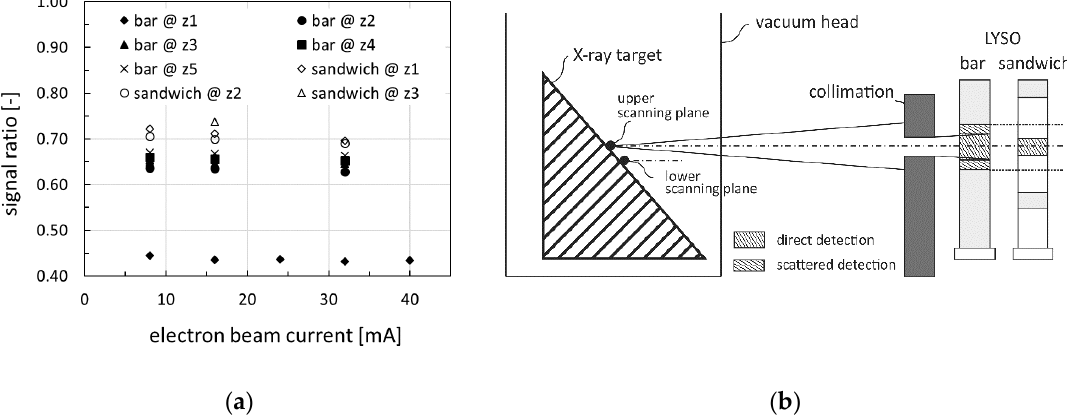
Figure 13. ( a ) Signal ratio between indirectly and directly exposed detectors for di ff erent electron beam currents, detector exposure heights, and MPD design configurations. ( b ) Sketch to illustrate the parallax e ff ect, as well as internally measured X-ray scattered